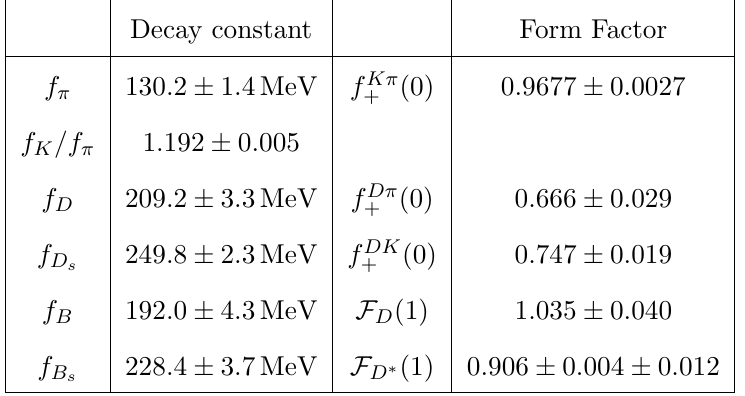
Table 7 . Contributions of the CP-odd combinations, Im ( V (cid:3) Here ~ c i (cid:17) v 2 Im C i and a \ (cid:0) " denotes that the contribution is negligible for our purposes.